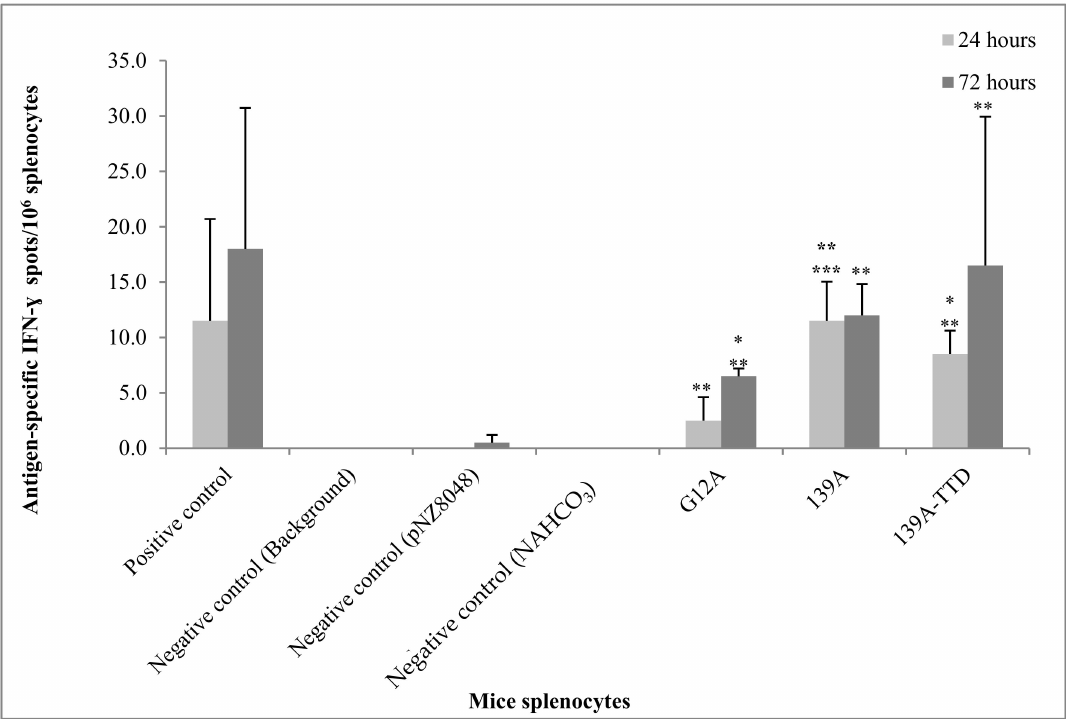
Figure 5. G12A-K-ras-specific cell-mediated immune (Th1) response of immunized mice. G12A-specific IFN- γ secreting T-cells were detected as spots via ELISpot assay. All immunised splenocytes were re-stimulated with G12A-K-ras control peptides. Positive control: splenocytes stimulated with PHA; negative control: (i) L. lactis expressing empty vector (pNZ8048) (ii) NAHCO 3 immunized splenocytes (iii) medium (background) stimulated with G12A-K-ras control mimotopes. Data are presented as mean ± standard deviation of duplicate assays. No spots were observed in all non-stimulated splenocytes. Mean values significant higher ( p -value ≤ 0.05) from * pNZ8048, ** NAHCO 3 , ** background control, ** non-stimulated and *** G12A